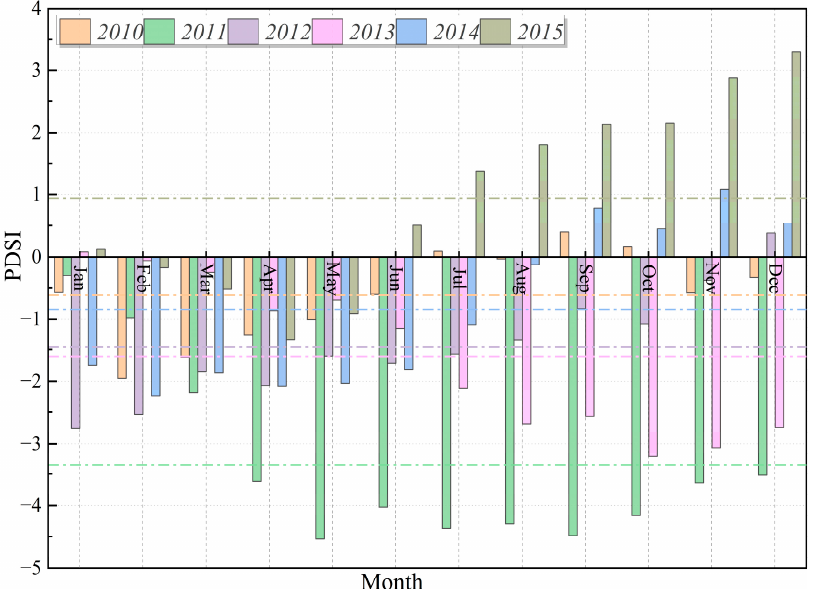
Figure 5. The monthly-averaged PDSI values of the middle and lower reaches of the Yangtze River in China from 2010 to 2015.